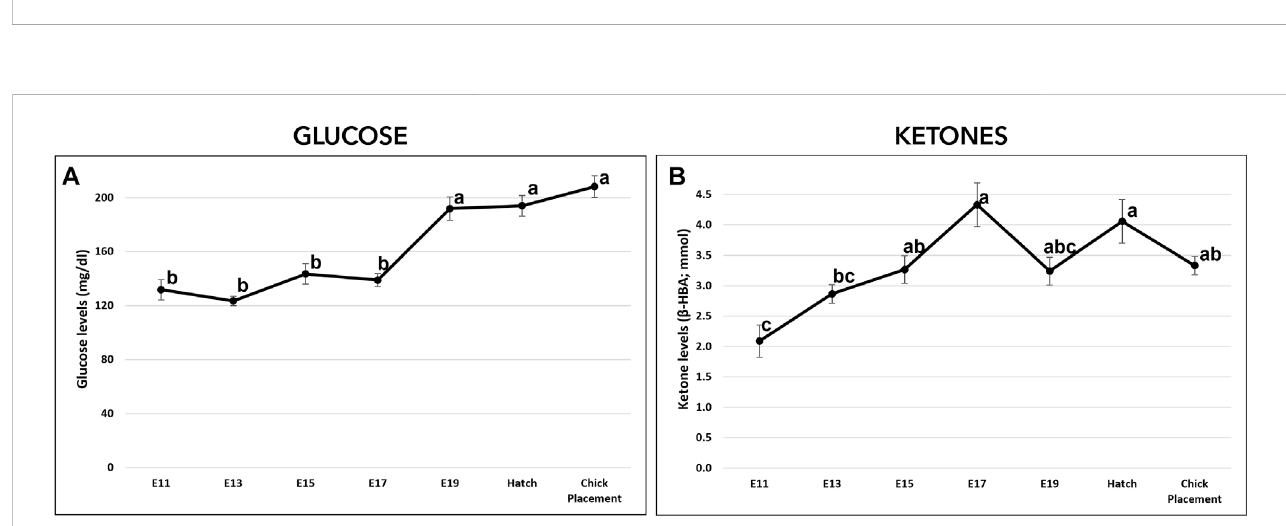
FIGURE 3 Glucose and ketones levels from E11 until hatch and at chick placement. (A) -Glucose (mg/di) and (B) -ketones ((3-HBA; mmol) were measured by FreeStyle Optimum Gluco/Keto meter. The lower-case letters denote for means signi fi cantly different between days, as derived from a one-way ANOVA Tukey ’ s HSD test ( p < 0.05), n = 6 per